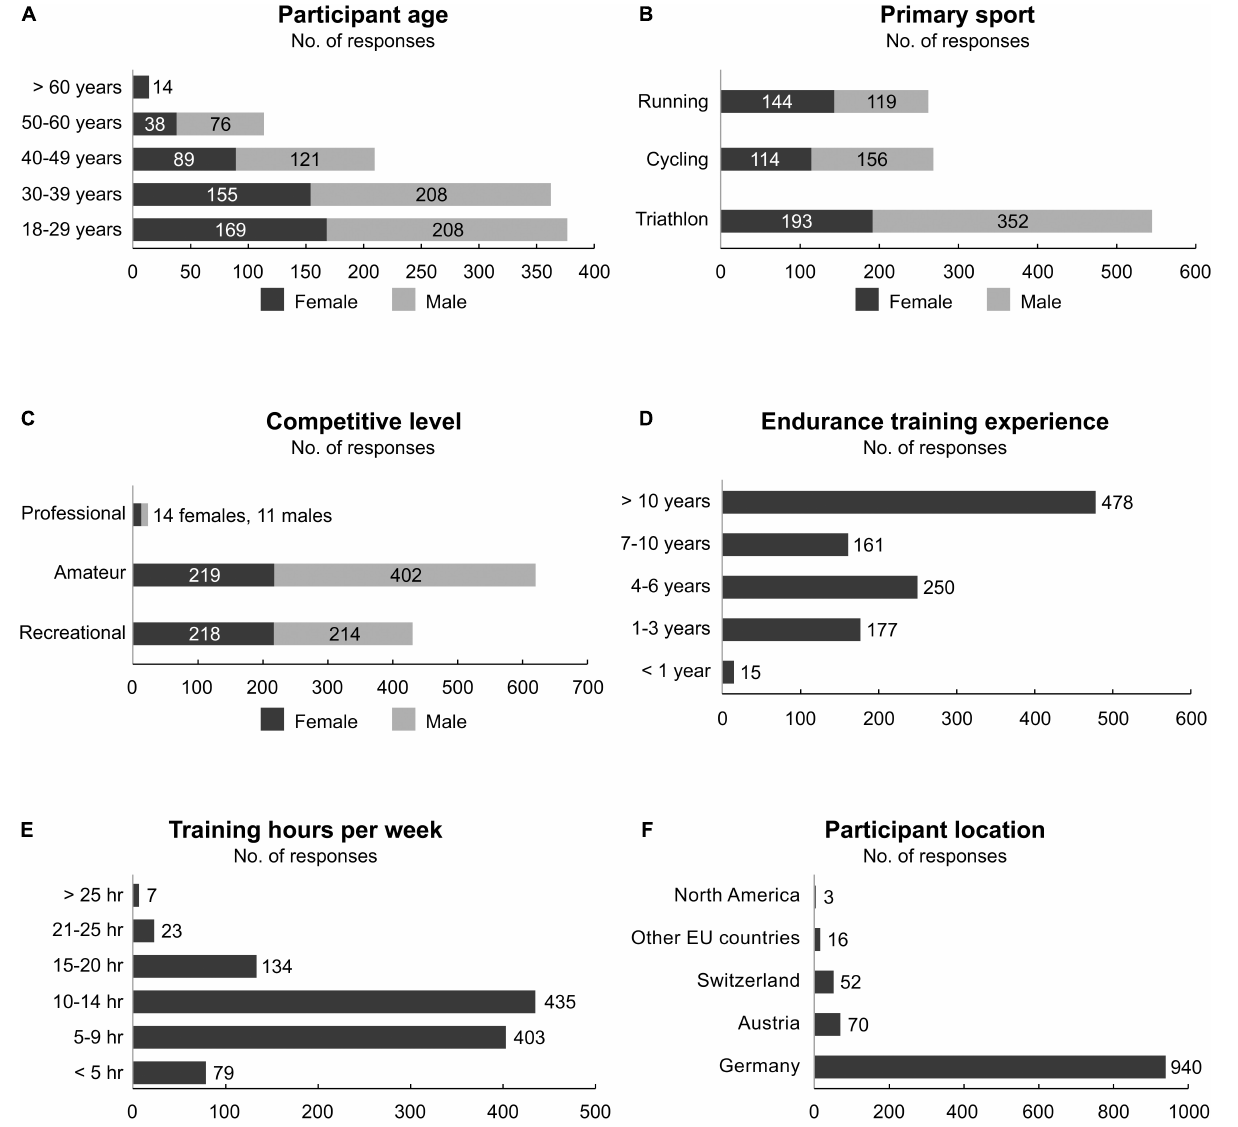
FIGURE 1 | (A) Age, (B) primary sport, (C) competitive level, (D) endurance training experience in years, (E) typical weekly training volume, and (F) participant location. N = 1,081, except (A–C) where two participants (amateur triathlete aged 18–29 years, and recreational cyclist aged 50–60 years) are diverse, and one participant (amateur triathlete aged 18–29 years) declined to give sex. For (F) , participants grouped by European (EU) countries were from nine different countries. The North America participants were from United States and